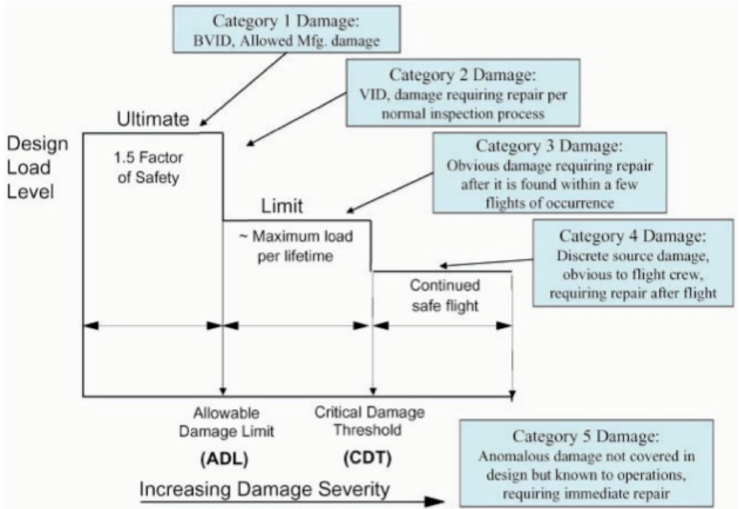
Figure 4. Design load levels versus damage severity as required by the Federal Aviation Authorities (FAA) (reproduced with permission from [44])